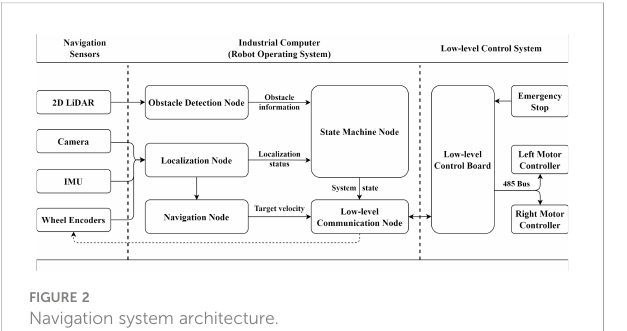
FIGURE 2 Navigation system architecture.